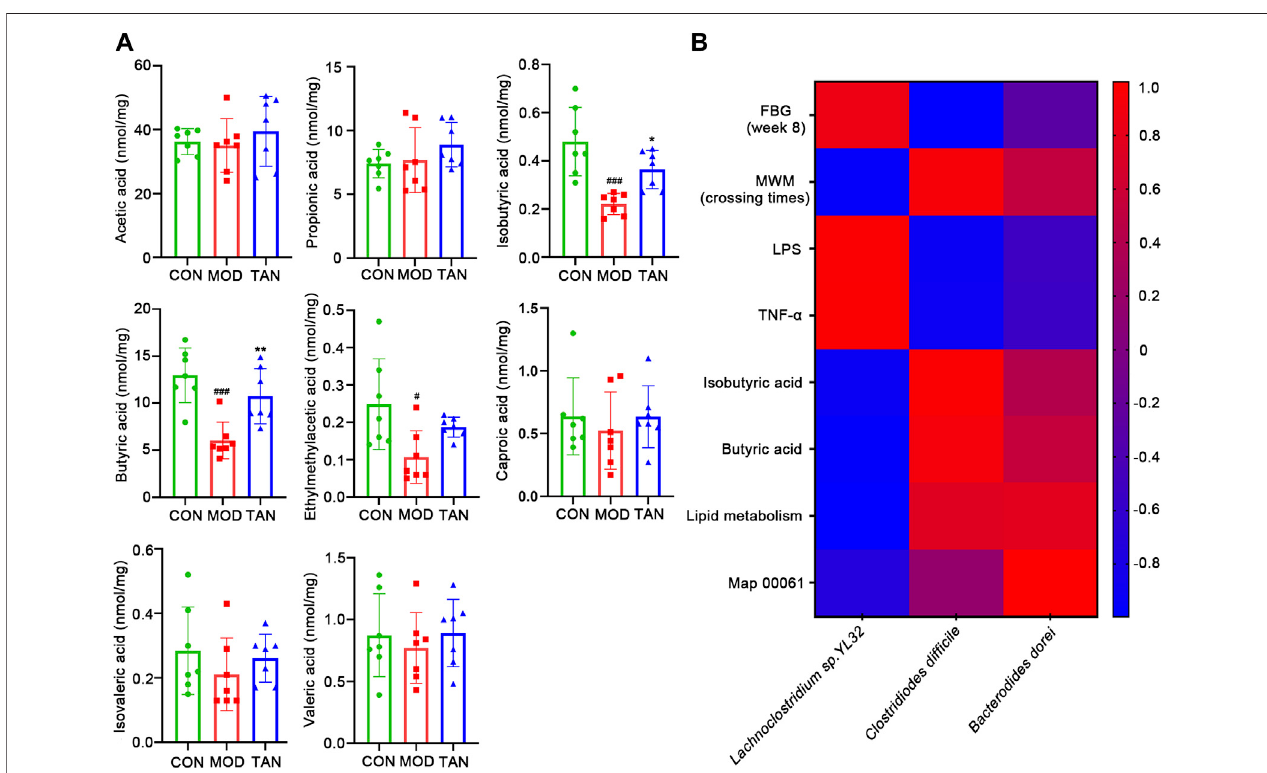
FIGURE8| TANrestoredthefecalSCFAsindiabeticrats,andthecorrelationbetweenthechangedspeciesrespondingtoTANandthediabetes-relatedindex( n = 7ratsineach group). (A) Comparison ofidenti fi ed SCFAsinthethree groupsanalysedbyone-wayANNOVA test. # p < 0.05, ### p < 0.001vs . CON groupand* p < 0.05, ** p < 0.01 vs . MOD group. (B) Correlation heat map of changed species responding to TAN and the diabetes-related index, including FBG, MWM (platform-crossing times), LPS, TNF- α , butyric acid, lipid metabolism, and map 00061. Red color represents positive correlation, and blue color represents negative correlation. TAN, tanshinone IIA; SCFA, short-chain fatty